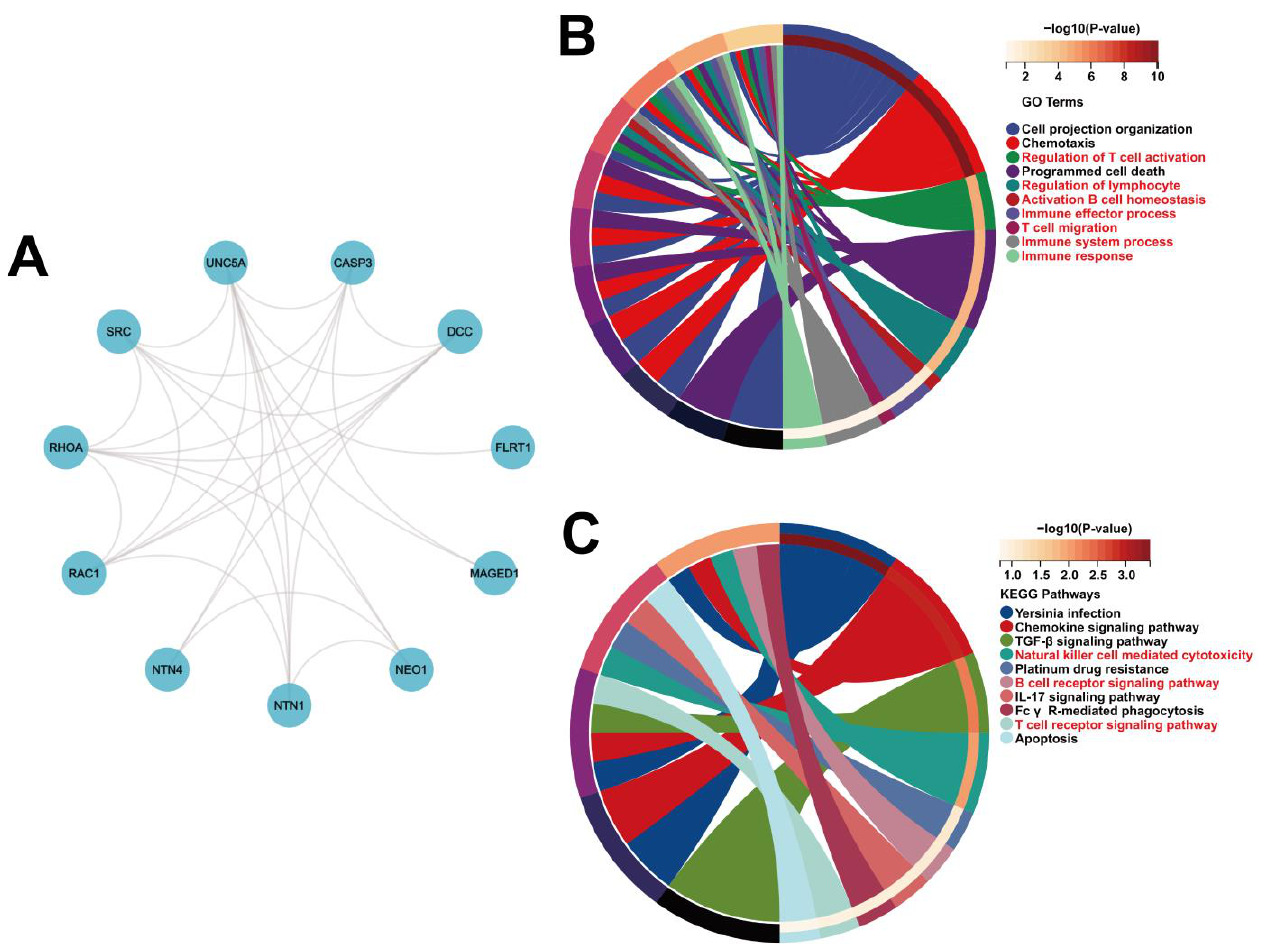
Figure 7. Enrichment analyses for UNC5A and the co-expression genes. ( A ) Protein-protein inter- action network of UNC5A and the co-expression genes (Top 10). ( B ) and ( C ) GO and KEGG analyses for UNC5A and the co-expression genes.